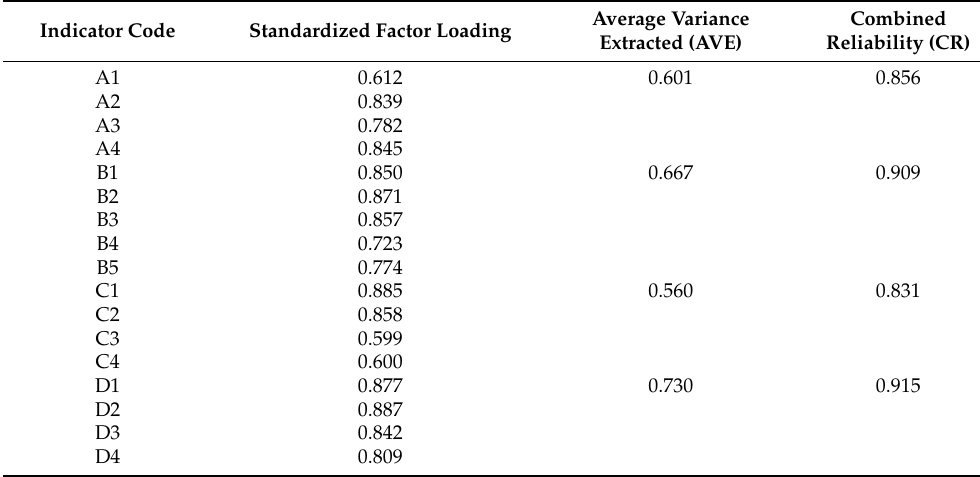
Table 9. Results of the convergent validity test for the questionnaire